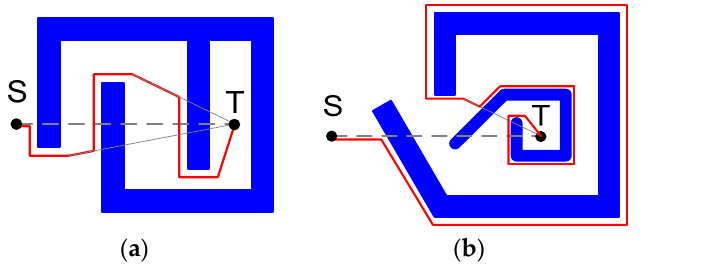
Figure 3. Improvement ( a ) and deterioration ( b ) of the vehicle movement based on the DistBug algorithm.